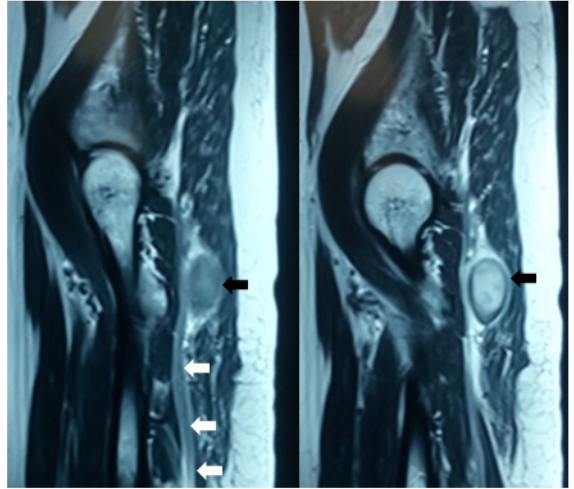
Figure 2. MRI scan revealing the unusual location of the tumor with a hypo-intense rim along the course of the sciatic nerve.